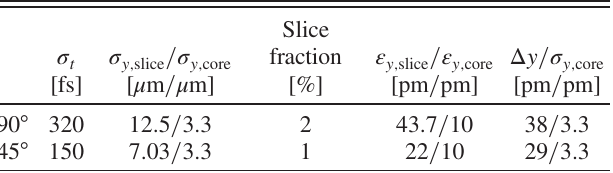
TABLE II. Quantitative comparison of 90° and 45° crossing